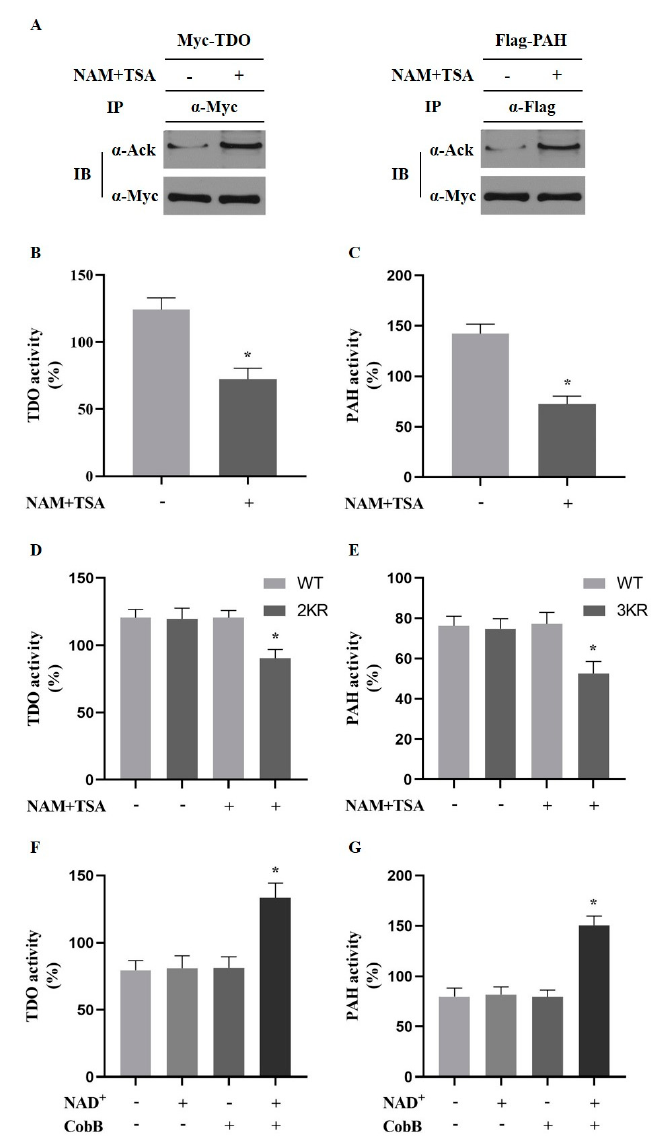
Figure 4. Acetylation of PAH and TDO modulates its activity. ( A ) Acetylation of PAH and TDO. PAH- Myc and Flag-TDO were expressed in HEK293T cells and acetylation were detected by immunoblotting. ( B – C ) Hepatic PAH and TDO enzyme activity of weaning piglets compared with control group. (Data are mean ± SD; n = 10 and * p < 0.05). ( D – E ) The activity of PAH and TDO with or without treatment of NAM and TSA in HEK293T cells. KR represents K-to-R mutation; WT represents wild-type (Data are mean ± SD; n = 10 and * p < 0.05). ( F – G ) PAH and TDO enzyme activity with or without CobB deacetylase. As an essential cofactor of CobB, NAD + was omitted as a negative control (Data are mean ± SD; n = 10 and * p < 0.05). (Data are mean ± SD; n = 10 and * p <